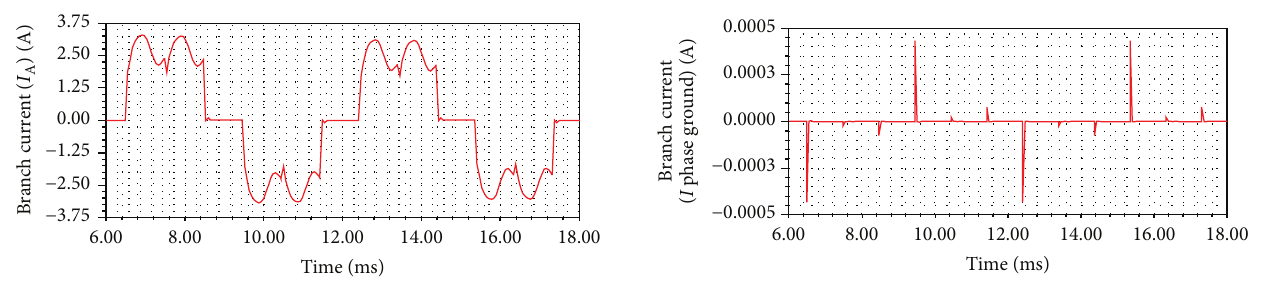
Figure 5: The phase current waveform (without filter).